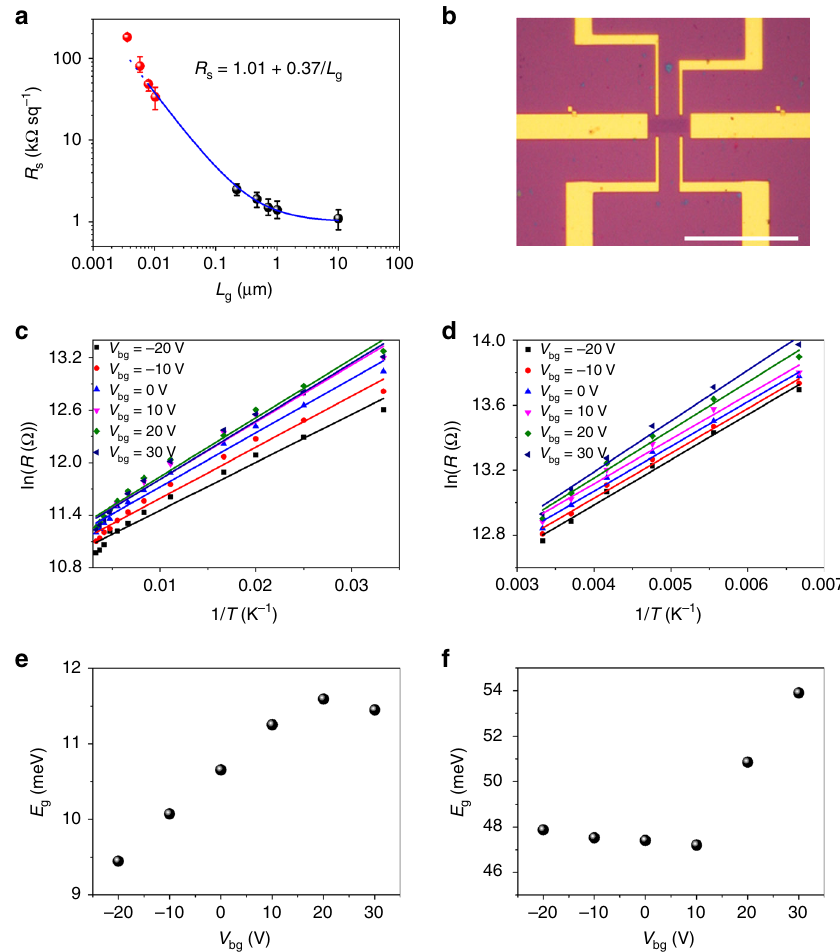
Fig. 6 Electrical transport properties of NG fi lms. a The sheet resistance as a function of grain size. The data of polycrystalline graphene fi lms with average grain size of ~220 nm, 470 nm, 720 nm, 1 μ m, and 10 μ m was reproduced from ref. [15]. The error bars show the variations of sheet resistance. The blue line is the fi tting curve to the equation R s = R Gs + ρ GB / L g . b Optical image of a Hall bar device made with a NG fi lm. c , d The resistance in ln scale as a function of the inverse of temperature for the 10.3 nm-grained c and 3.6 nm-grained d NG fi lms at different values of gate voltages. The temperature range is 30 – 300 K for 10.3 nm-grained NG and 150 – 300 K for 3.6 nm-grained NG. The lines are the fi ttings to the equation R ( T ) ∝ exp ( E a / kT ), showing activated behavior. e , f The extracted bandgaps as a function of gate voltage for the 10.3 nm-grained e and 3.6 nm-grained f NG fi lms. Scale bar: b , 20 μ